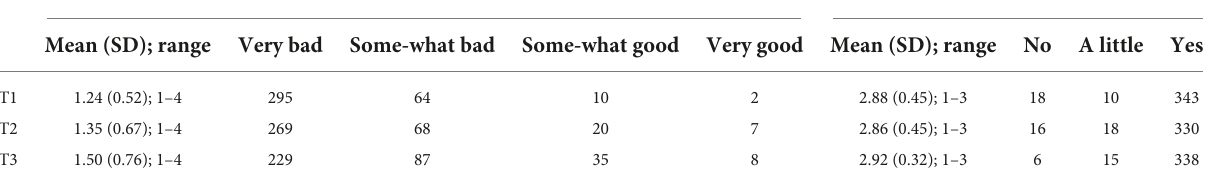
TABLE 1 Descriptive statistics and endorsement pattern for affect toward and perceived risk of cigarette use